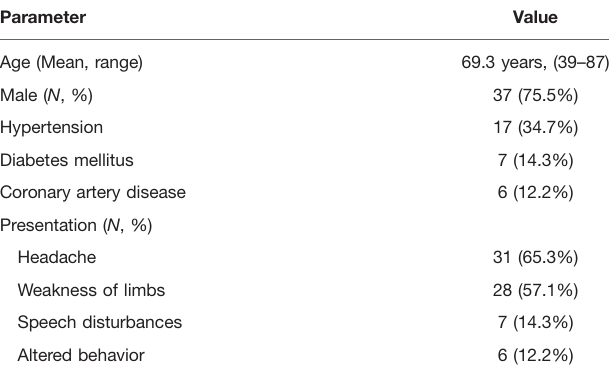
TABLE 1 | Summary of demographics, comorbidities, and presentation ( N =49 patients). Parameter